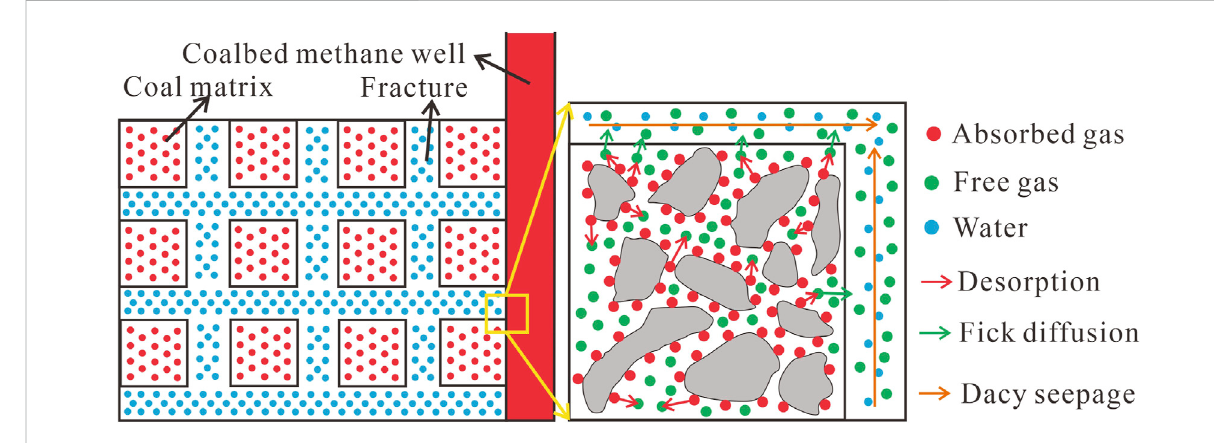
FIGURE 2 Theoretical model of the dual porosity and single permeability model (Qin et al., 2020).